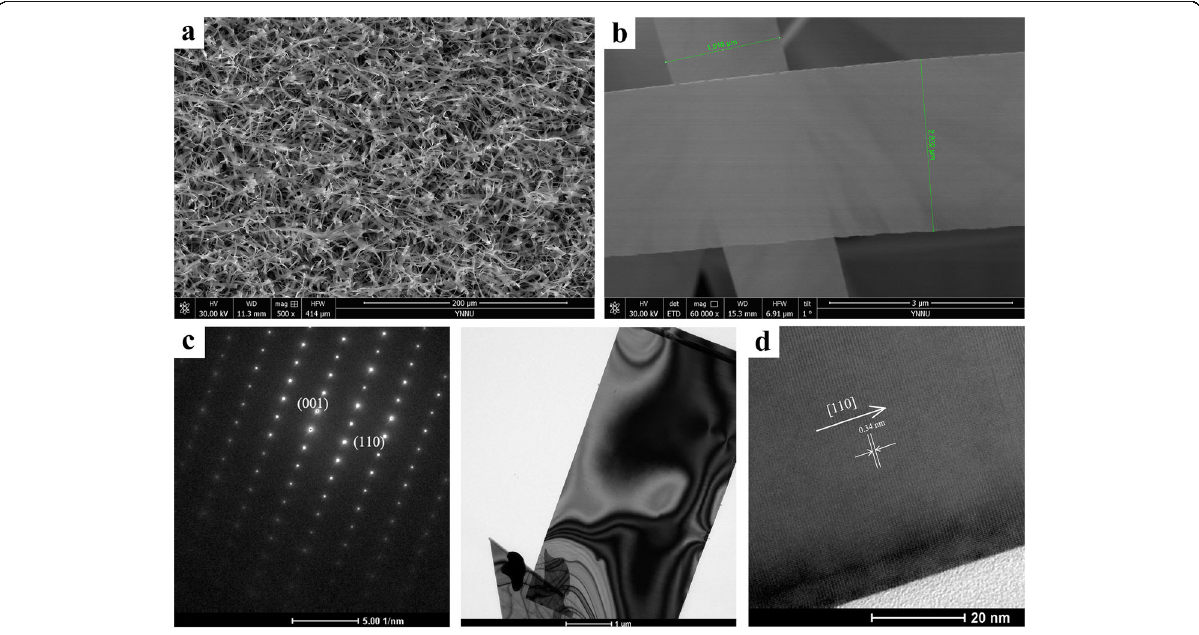
Fig. 2 The morphology images of CdSSe NBs. a SEM at low magnification. b SEM at high magnification. c SAD, inset: its TEM. d